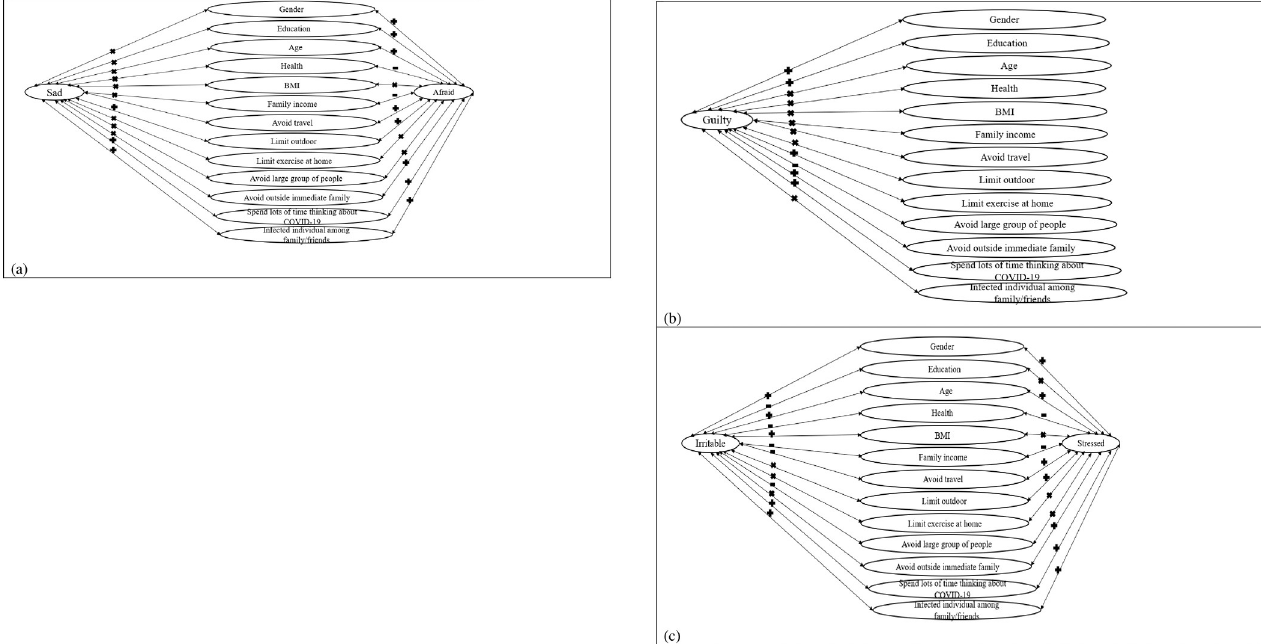
Fig 1. Associations between various negative emotions and students behaviors, and characteristics, positive, negative and no associations are highlighted by “+”,”-“, and “ × ”.